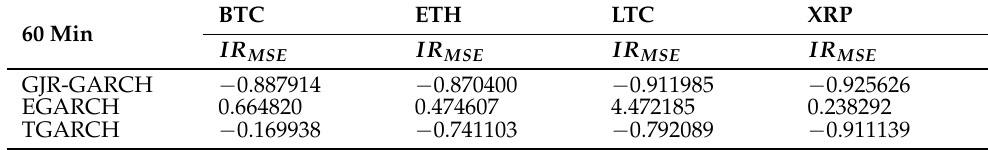
Table 7. Comparison of forecasting methods improvement in terms of MSE.